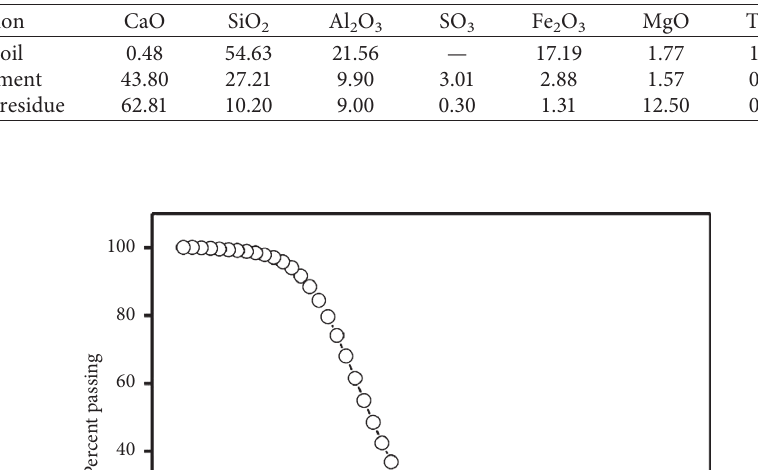
Table 2: Major chemical components of the tested soil and binders.